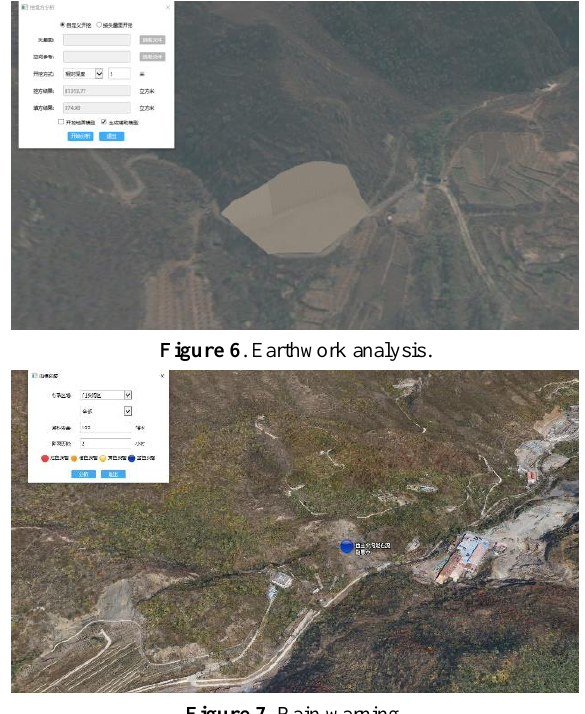
Figure 7 . Rain warning.